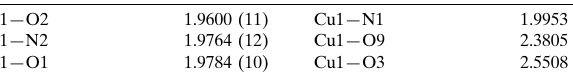
Selected bond lengths (A˚ ).